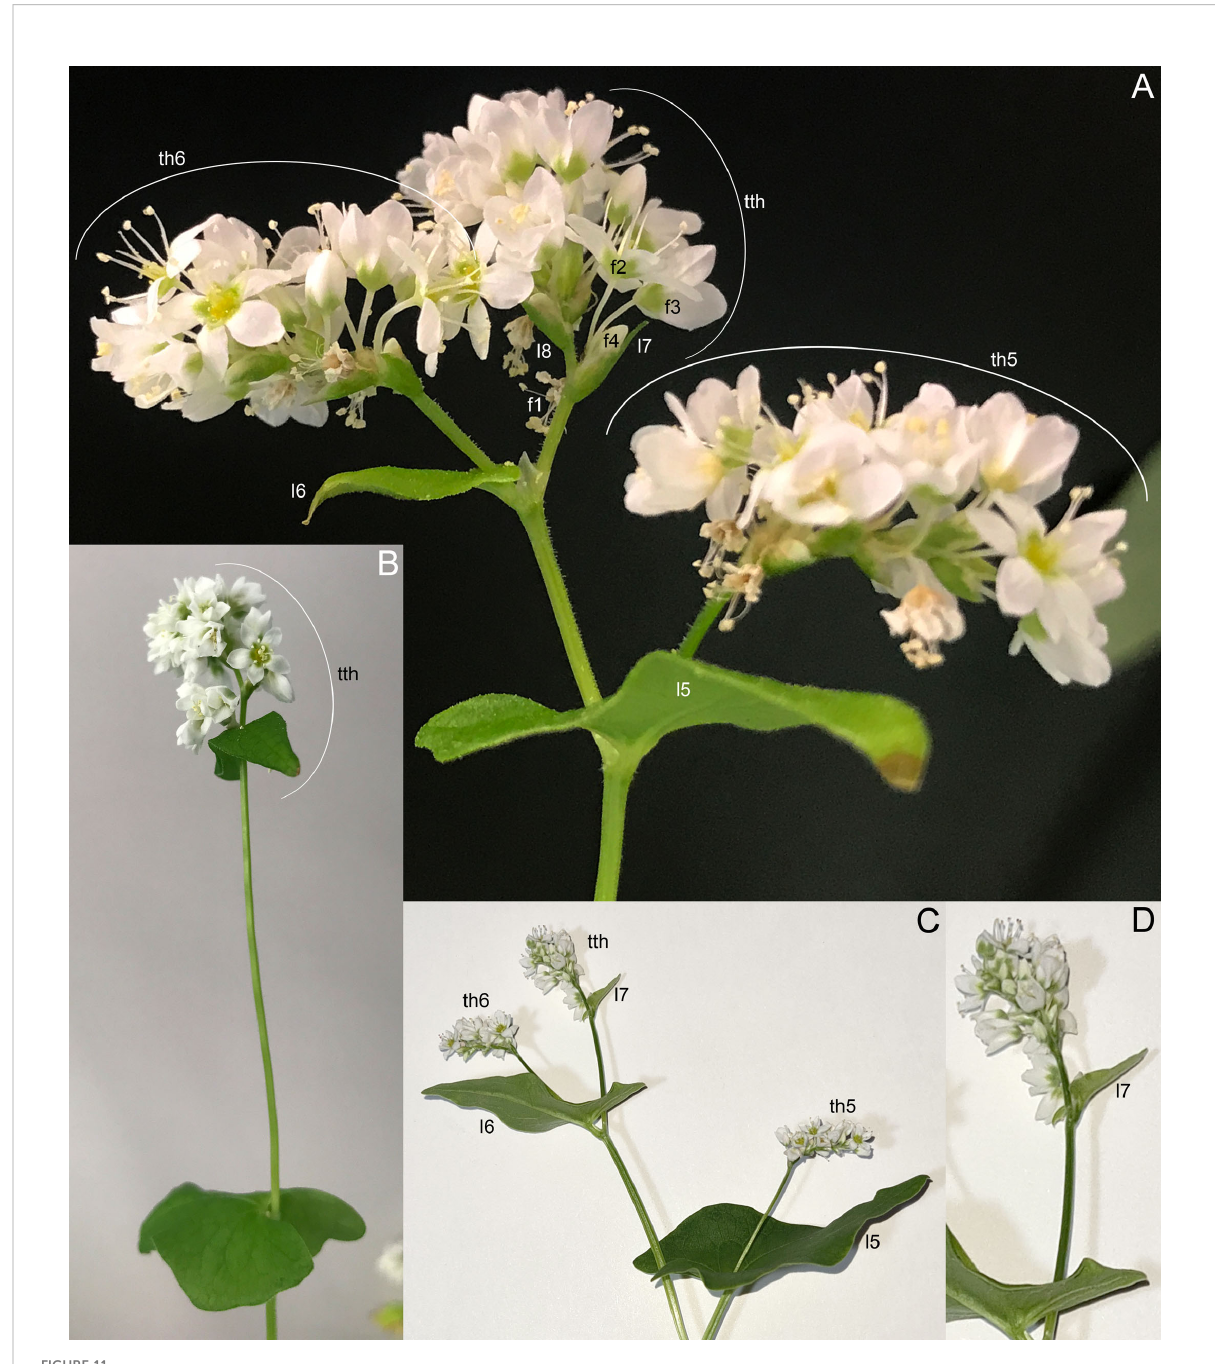
FIGURE 11 In fl orescence morphology of cultivars of Fagopyrum esculentum subsp. esculentum with determinate growth. (A, B) cv. Dasha. (A) Plant with a terminal and two lateral thyrses situated in axils of leaves 5 and 6 of the main axis. Leaf 7 is scale-like and subtends the fi rst cyme of the terminal thyrse. (B) Plant with the entire in fl orescence composed of a terminal thyrse. The fi rst cyme of the terminal thyrse is subtended by a foliage leaf. (C, D) cv. Temp. Plant with a terminal and two lateral thyrses situated in axils of leaves 5 and 6 of the main axis. Leaf 7 is a foliage leaf and subtends the fi rst cyme of the terminal thyrse. (D) is a detail of (C) showing the terminal thyrse. f1, f2, f3, f4, successive fl owers of the fi rst cyme of the terminal thyrse, f1 is postanthetic, unfertilized, f4 is a bud; l5, l6, l7, l8, phyllomes of the main axis counted starting from the fi rst leaf above the cotyledons; th6, th7, thyrses in axils of leaves 6 and 7; tth, terminal